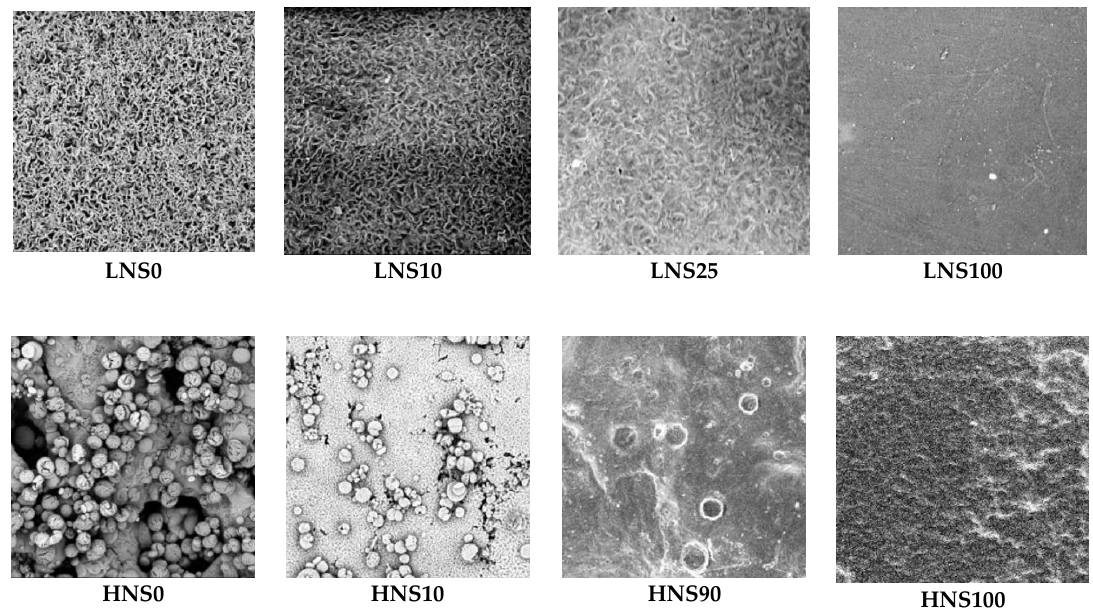
Figure 1. Selected scanning electron microscopy (SEM) images of (top) nylon610-silk (LNS) blend films and (bottom) nylon1010-silk (HNS) blend films. (each image scale is 150 µm ×150 µm).